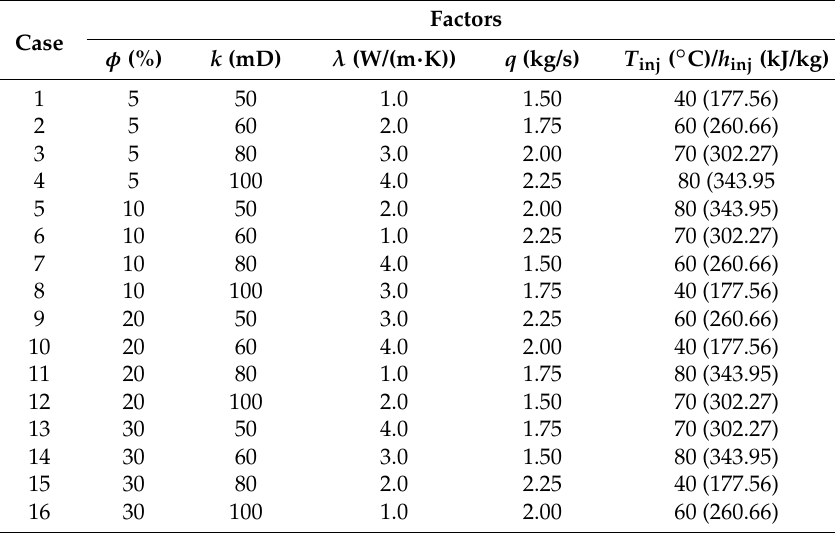
Table 2. Sixteen representative combinations of the geological